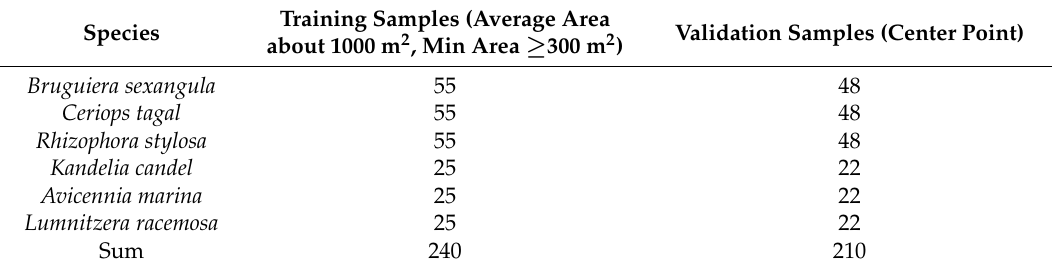
Table 2. Number of training and validating samples for each mangrove